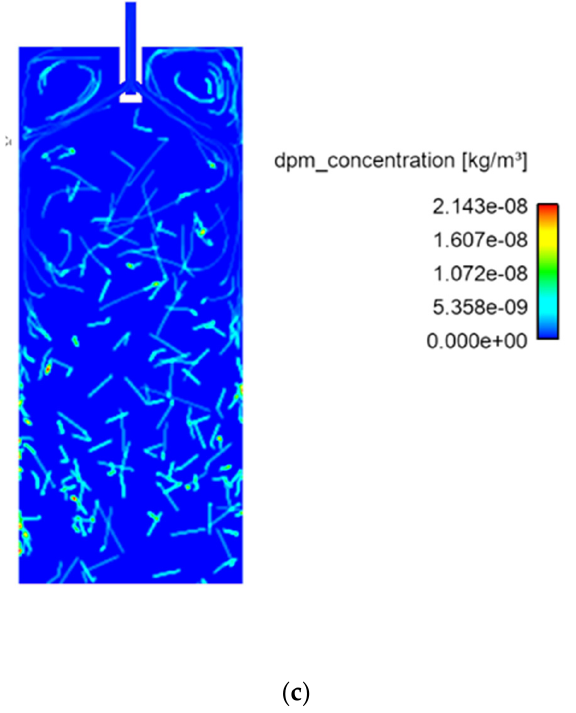
Figure 9. Inclusion concentration profile in the mold at 1853 K; diameter size: ( a ) 5 microns, ( b ) 100 microns, and ( c ) 300 microns.